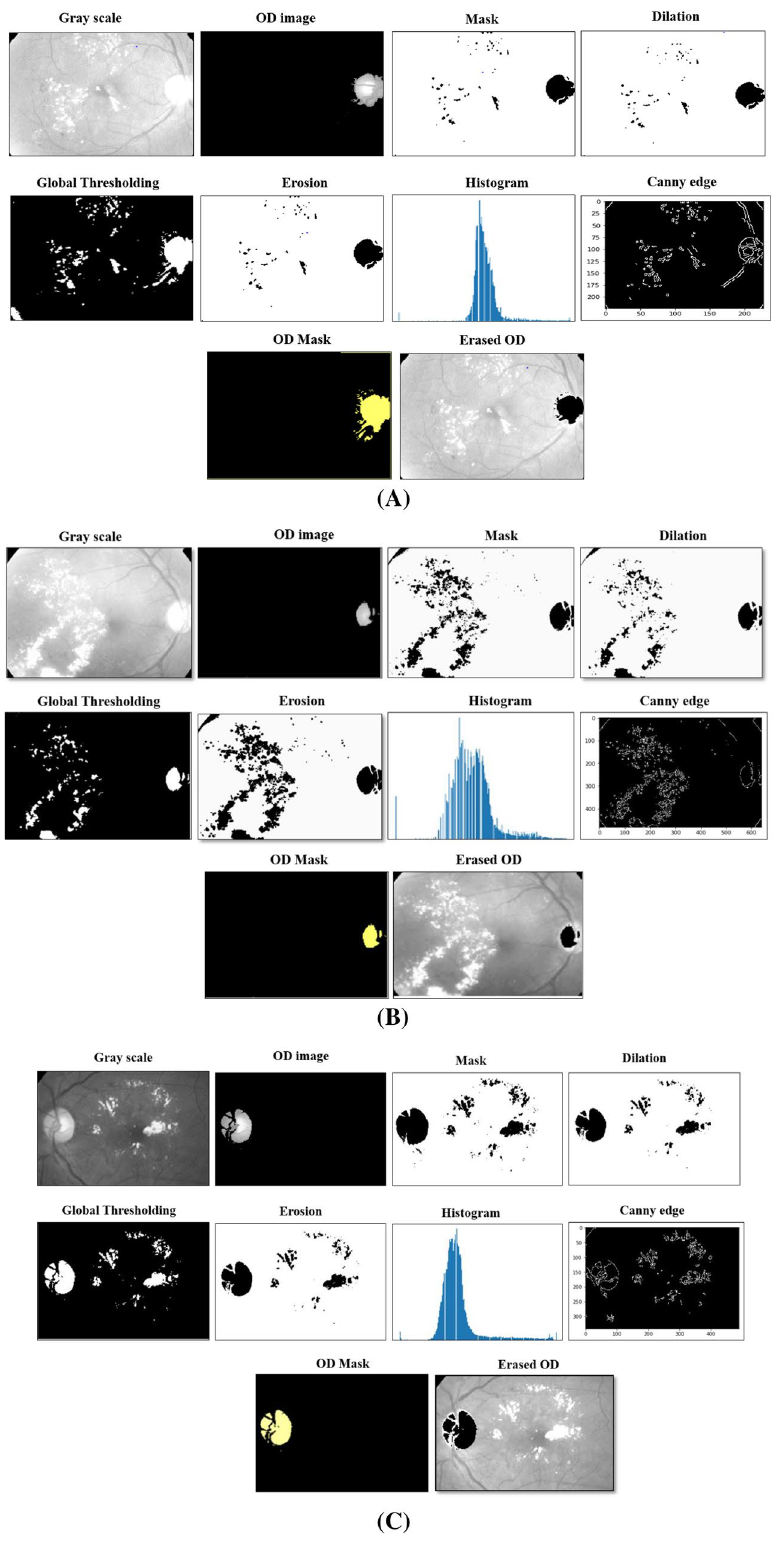
Figure 3. Optic disk removal detection ( A – C